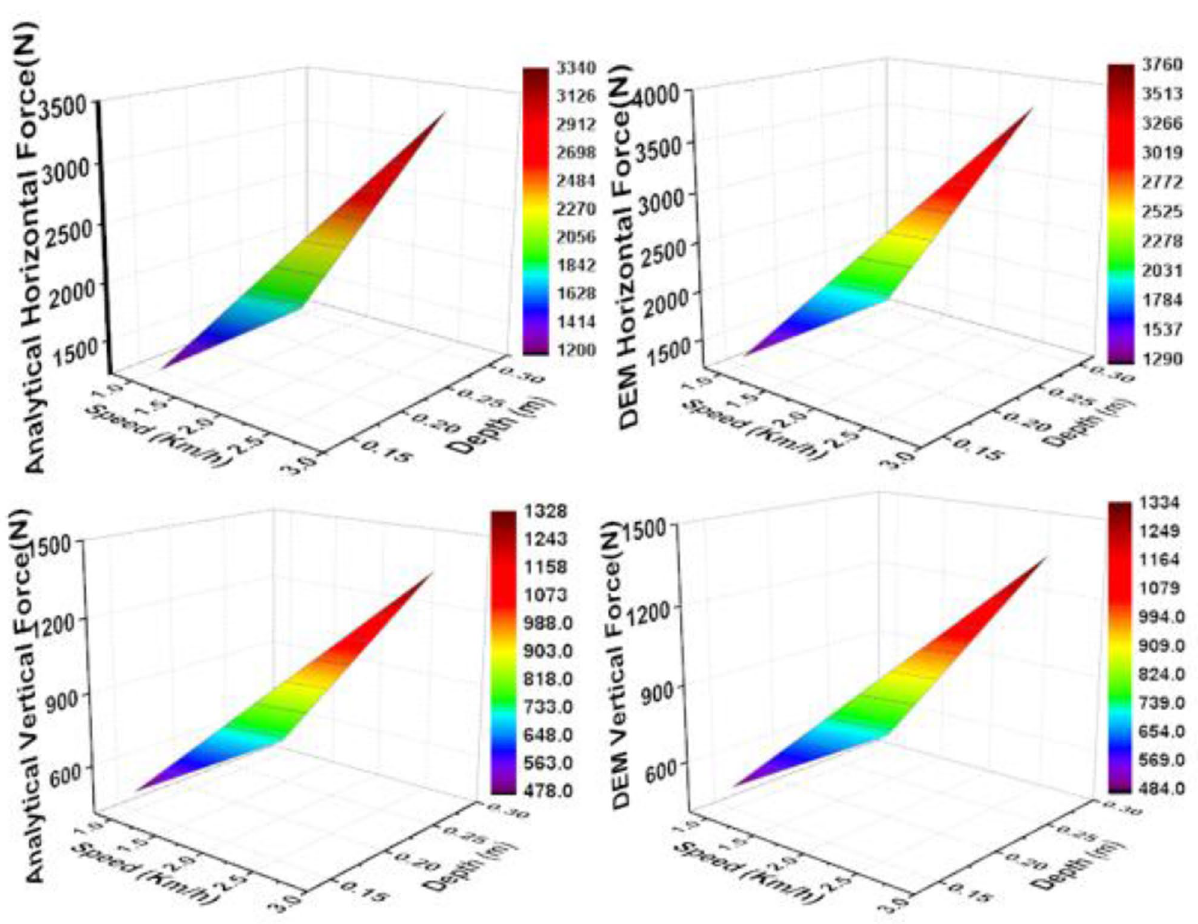
Figure 9. The prediction of cutting forces of the subsoiler during tillage operations ( A ) Analytical horizontal force ( B ) DEM horizontal force ( C ) Analytical vertical force ( D ) DEM vertical force.